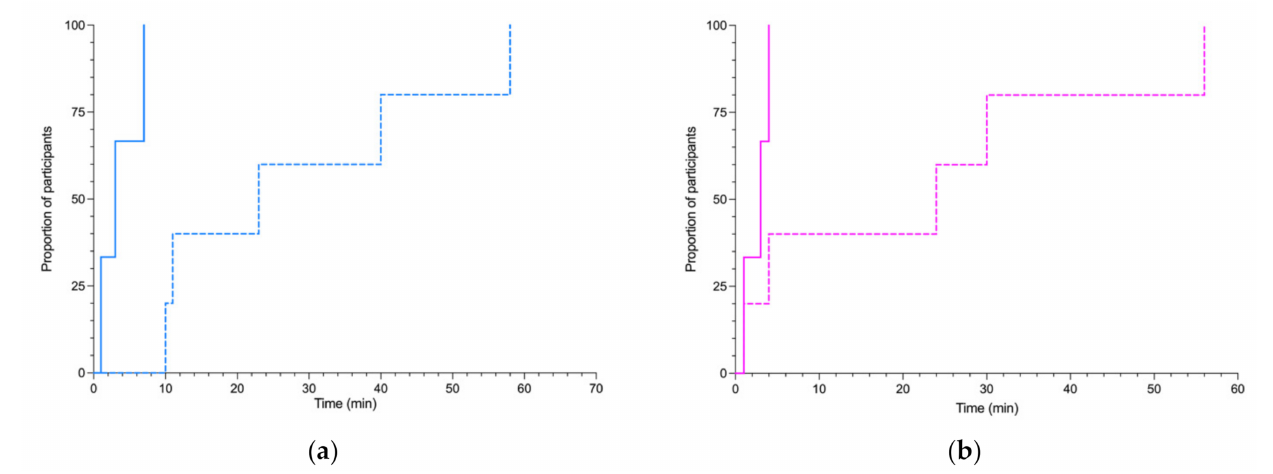
Figure 4. Time to laboratory consideration and to find a colleague. ( a ) Kaplan–Meier curves of time elapsed from the laboratory report to consideration of results and ( b ) time from request to find a colleague to a physical connection using the PIMPmyHospital app (plain lines) vs conventional methods (dashed lines). Log-rank (Mantel–Cox) test comparing curves: χ 2 = 8.2 and p = 0.004 for laboratory results; χ 2 = 2.7 and p = 0.1 for finding a